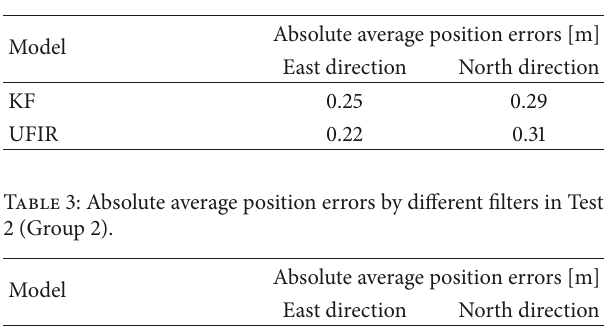
Figure 5: Trajectory measured by INS + ZUPT + KF for the second group of possible parameters (Group 2). Table 2: Absolute average position errors by different filters in Test 1 (Group 1).